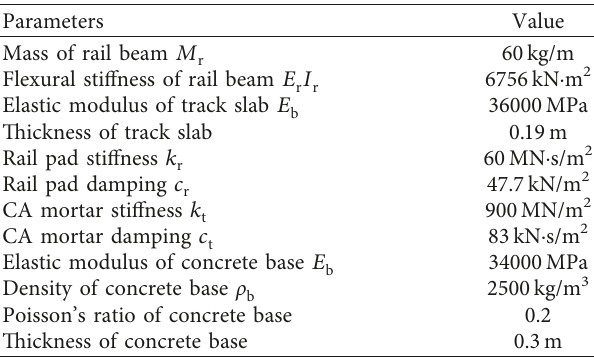
Table 2: Parameters of slab track